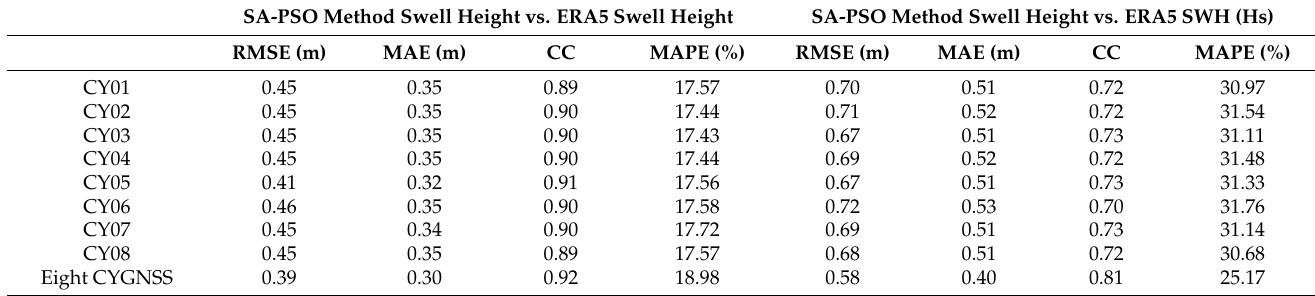
Table 4. RMSE, MAE, CC, and MAPE statistics by comparing the swell height results retrieved using the SA-PSO method with ERA5 swell height and ERA5 SWH